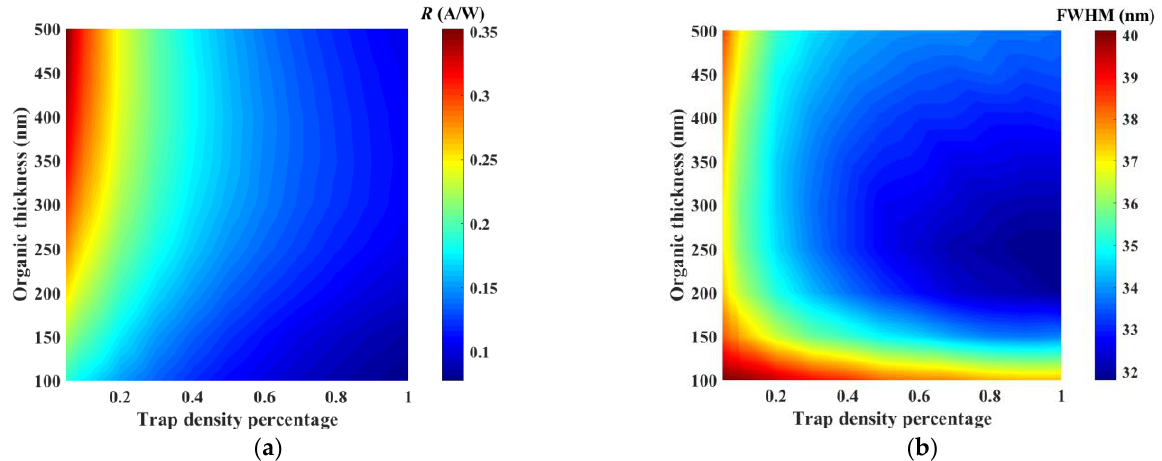
Figure 7. Contour plots representing the impact of organic thickness and trap density on ( a ) peak responsivity and ( b ) FWHM.